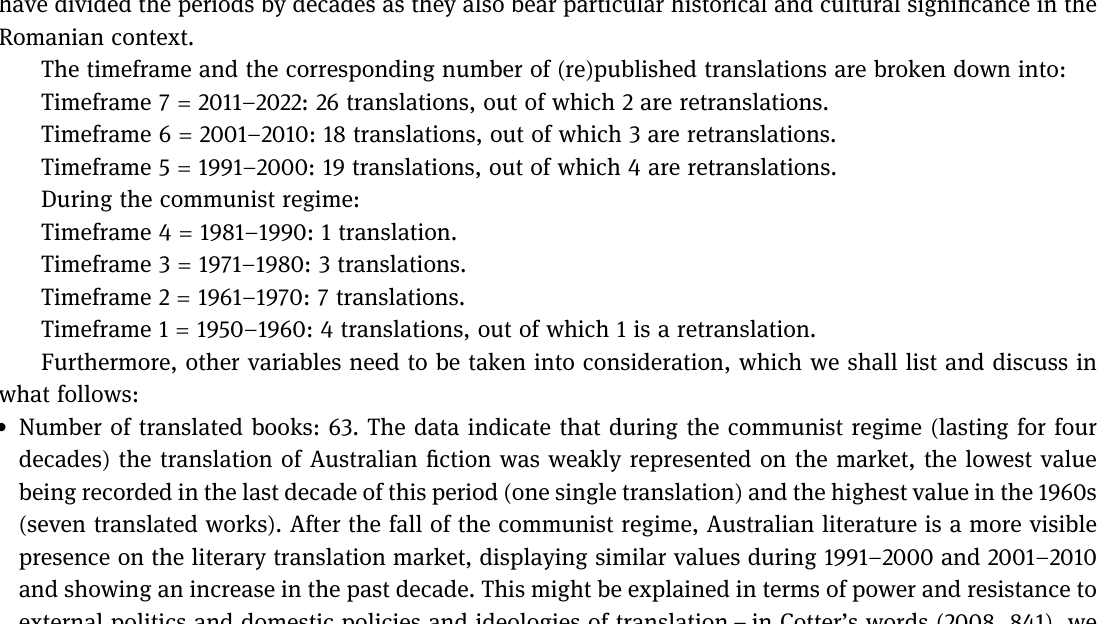
Figure 1 correlates the number of published ( re ) translations with the corresponding period of time – we have divided the periods by decades as they also bear particular historical and cultural signi fi cance in the Romanian